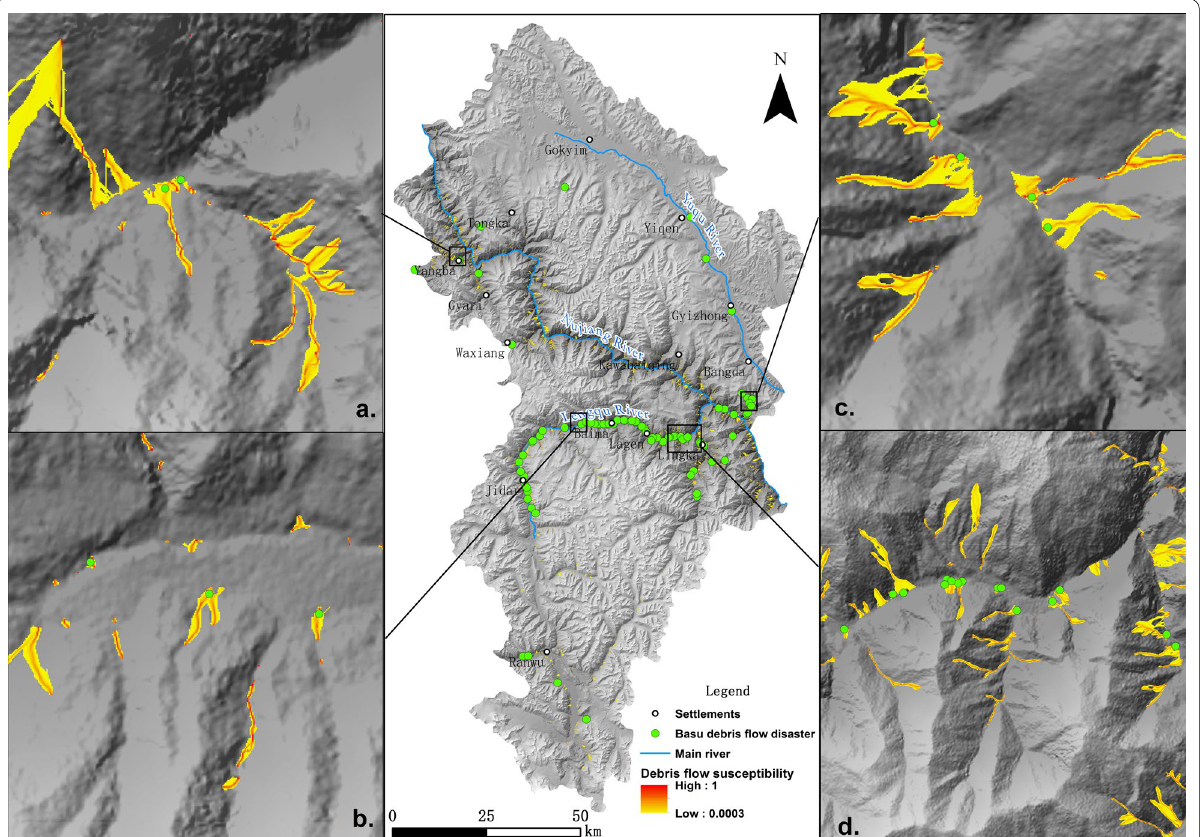
Fig. 5 Comparison between actual debris flow disaster points and Flow-R model